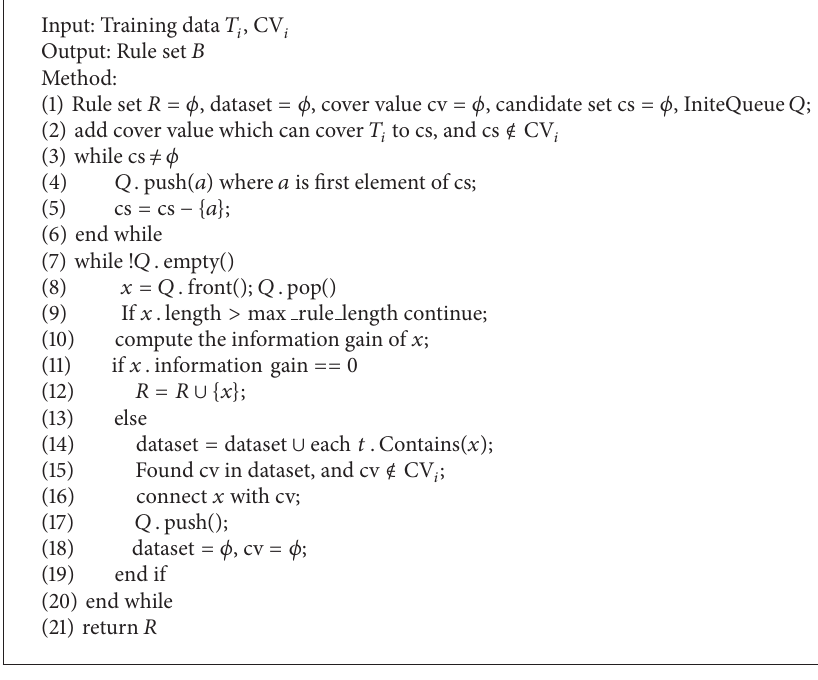
Algorithm 4: Inducing rule set 𝐵 .